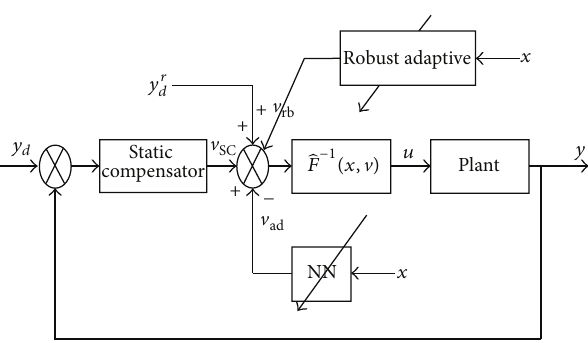
Figure 5: Robust adaptive inversion control based on neural